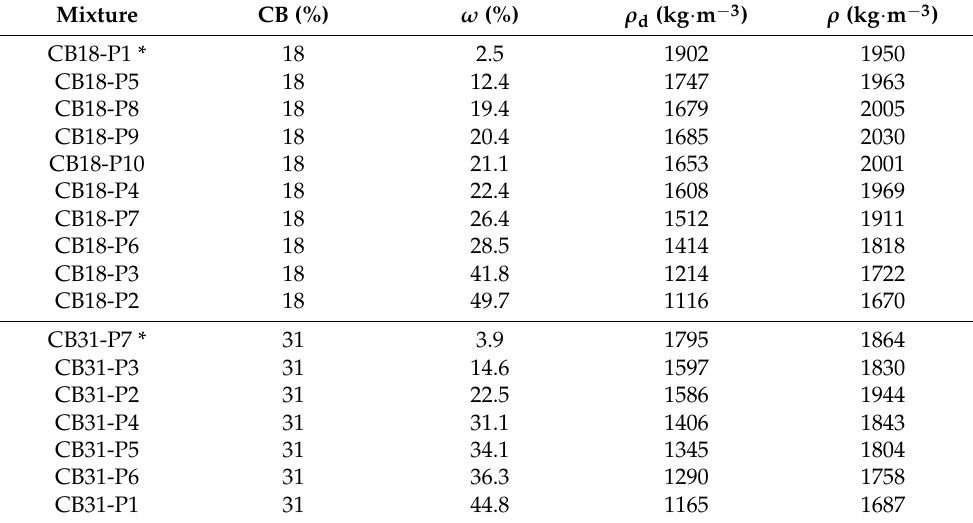
Table 5. Summary of the standard Proctor